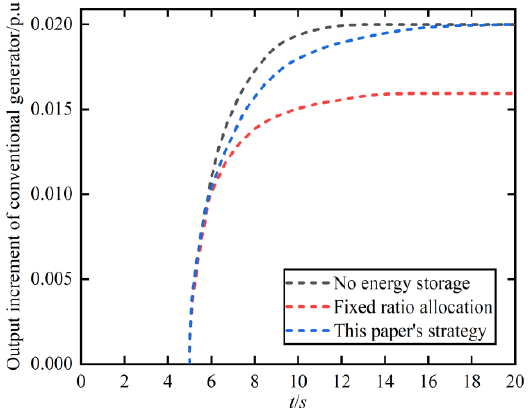
Figure 10. Output increment of conventional generator.